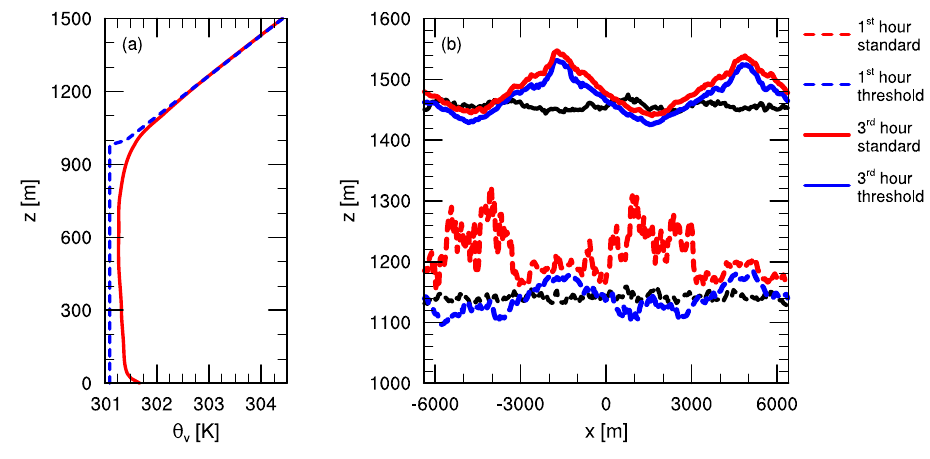
Fig. 2. (a) The initial profile in blue and the profile after 30min in red for the virtual potential temperature as a function of height. The profile is calculated for an arbitrary position in the area towards which warm air is advected in the top of the boundary layer. In (b) the boundary layer heights as determined by the maximum gradient and the threshold gradient methods are shown as a function of the x- position in respectively red and blue. As a reference, the boundary layer height over a homogeneous surface, as determined by the maximum gradient method, is shown in black. The dashed and solid lines show the boundary layer heights averaged over the first and third hour of the simulation, respectively. The relatively cold forest patches are located at − 6400m <x < − 3200m and 0m <x < 3200m. Here, the boundary layer is shallower than over the relatively warm savannah